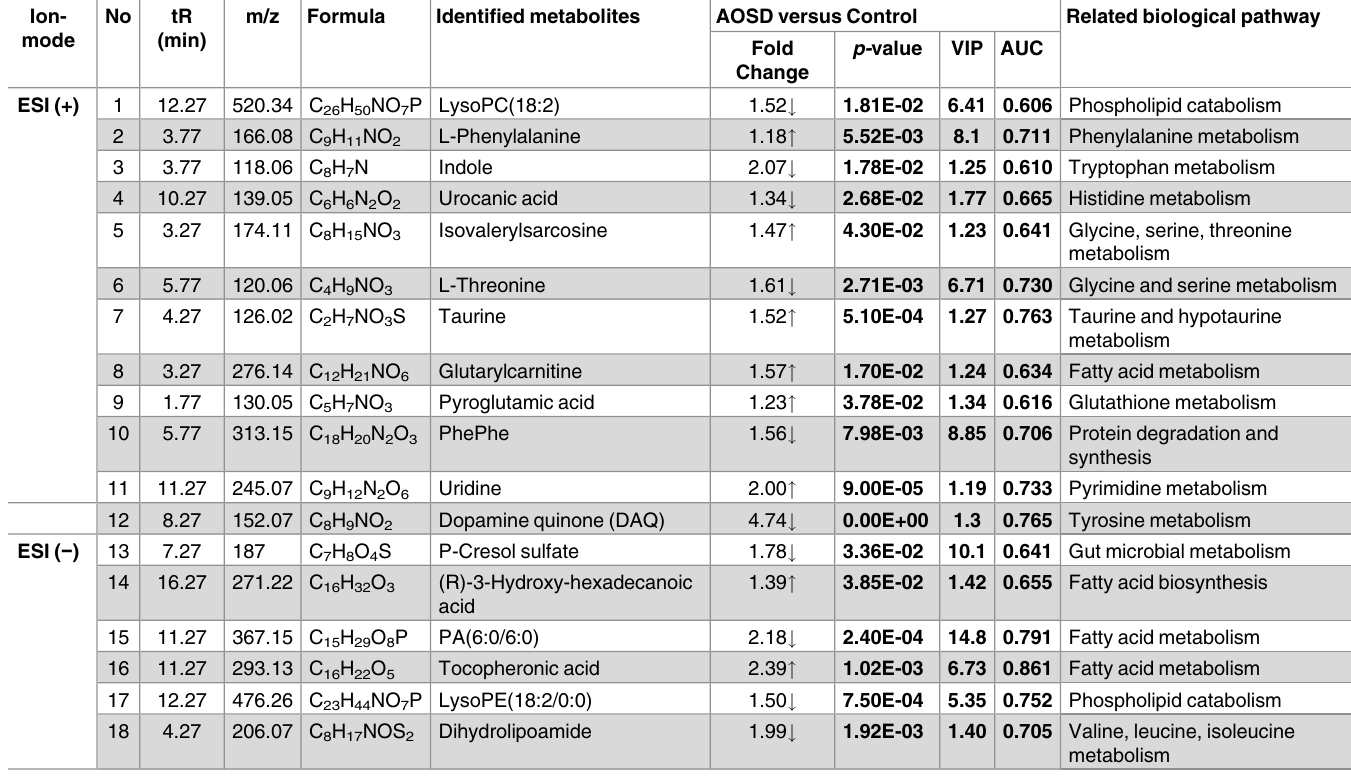
Table 2. Eighteen differentially expressedmetabolites identified in AOSD relative to healthy control in the first stage of metabolomics analysis.